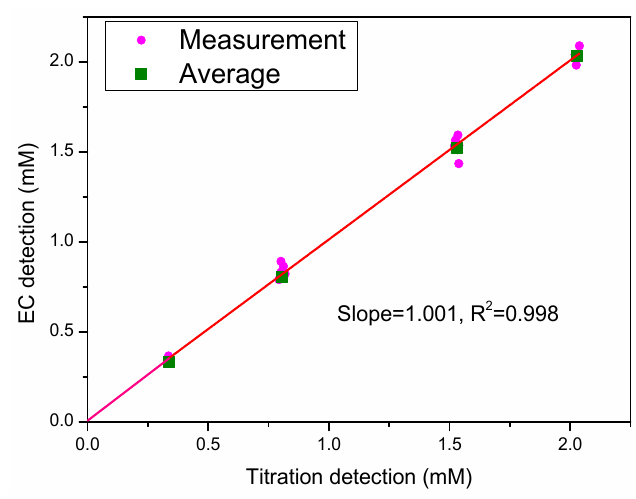
Figure 4. The relationship of DIC determination between titration detection and this study.